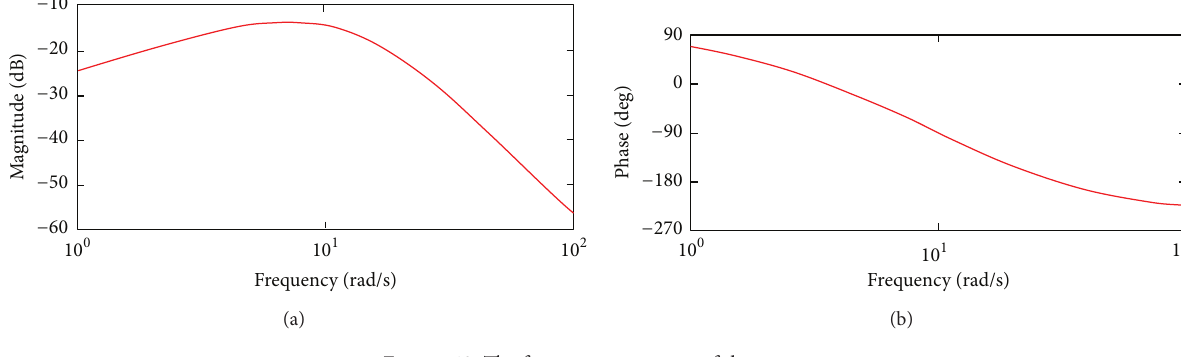
Figure 10: The frequency response of the system.